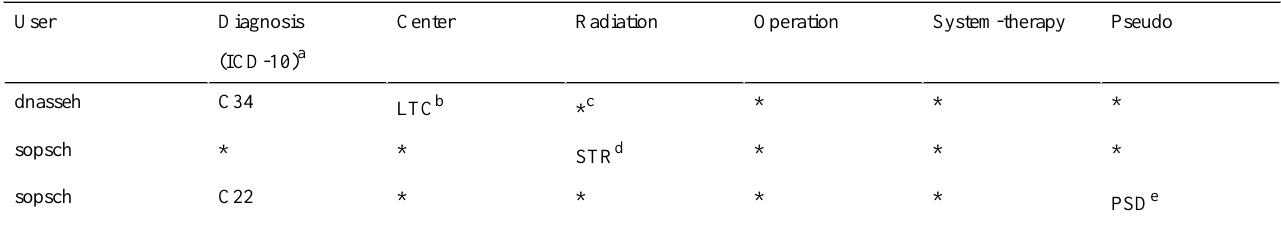
Table 1. Example of a permission table for user access.